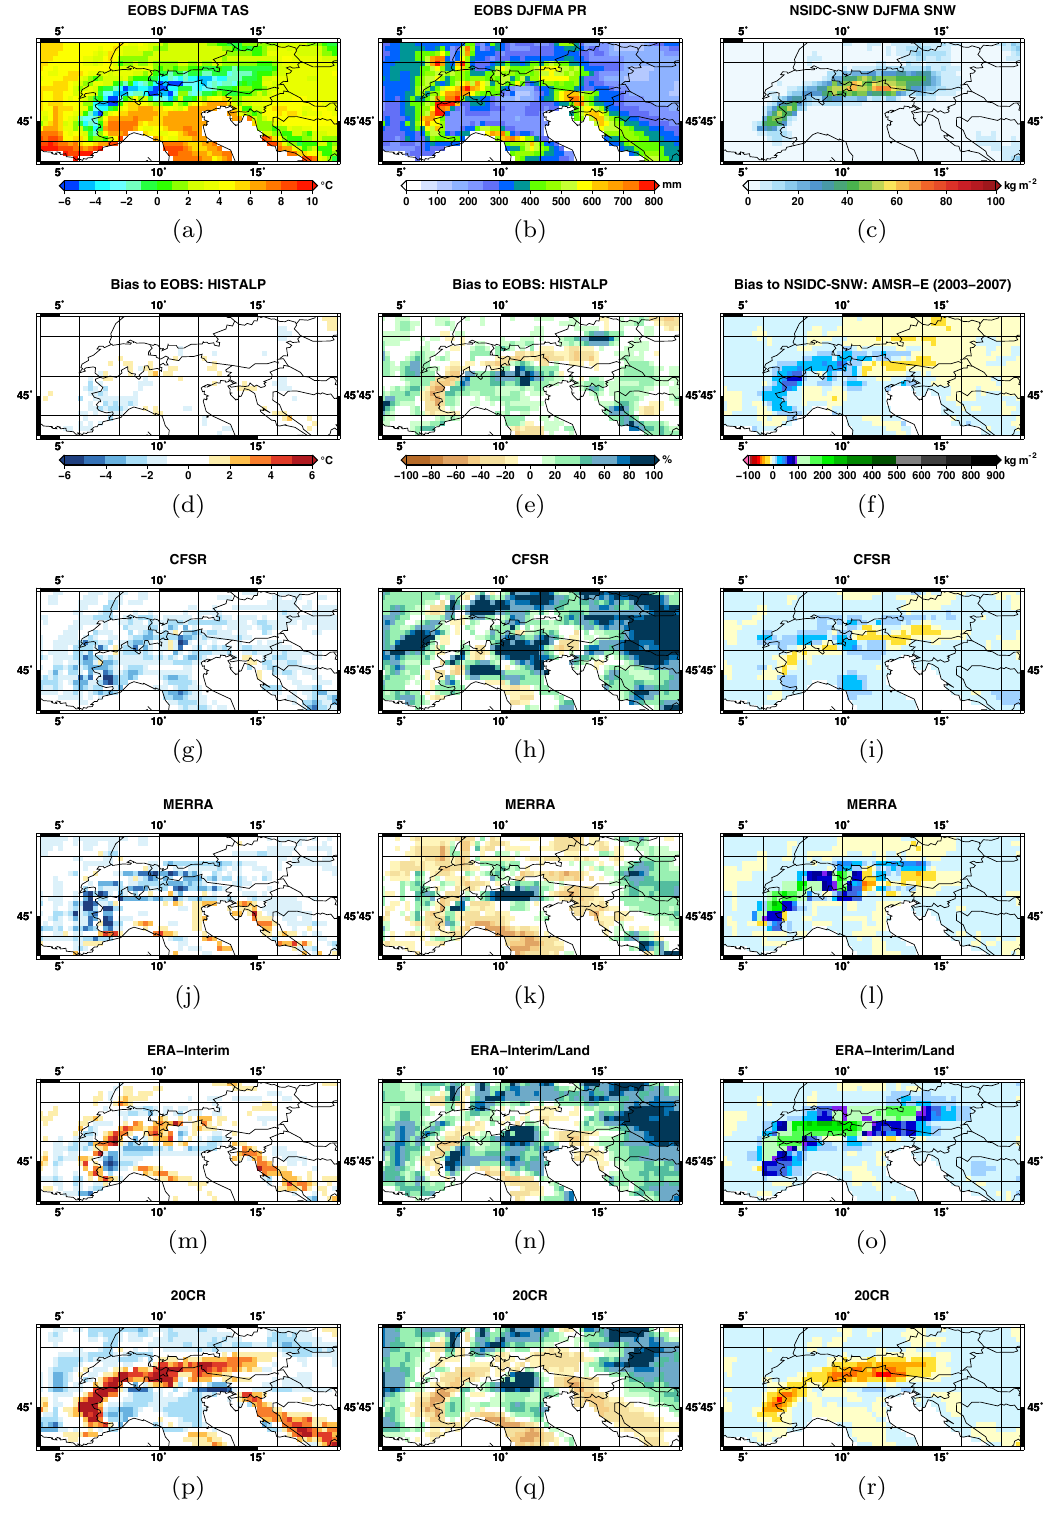
Figure 2. Multiannual mean (1980–2005) of the DJFMA average (a) air temperature, (b) total precipitation from EOBS observational data sets and (c) snow water equivalent from NSIDC-SNW. Panels from (d) to (r) represent the bias of HISTALP, AMSR-E and reanalyses with respect to EOBS and NSIDC-SNW data sets